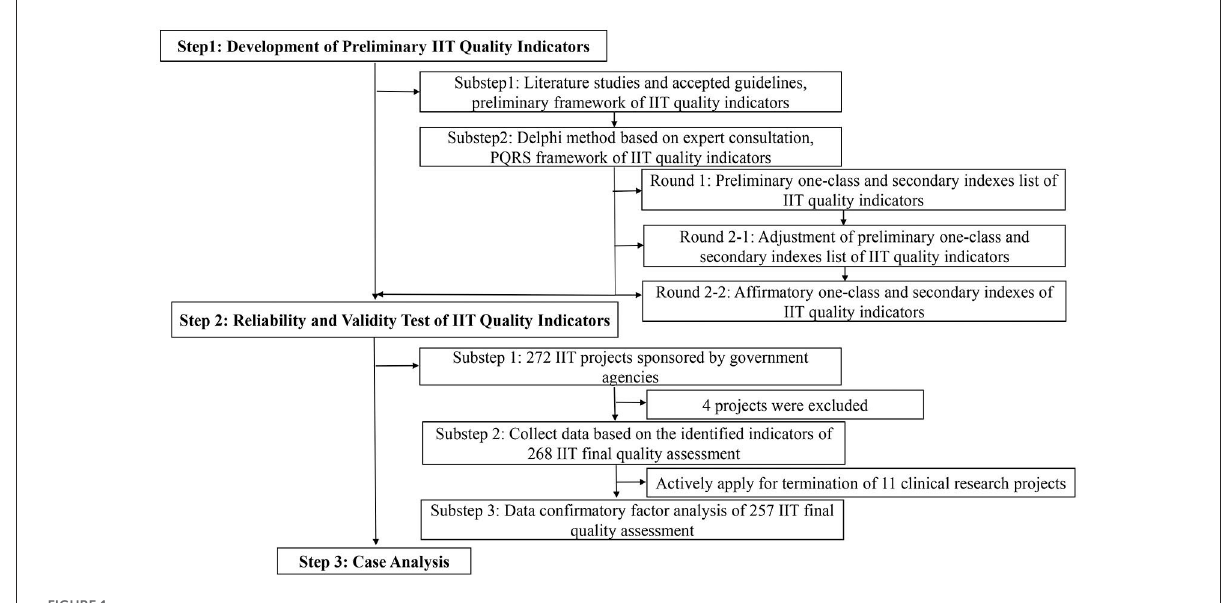
FIGURE1 Flowchart of development and validation of quality assessment tool for